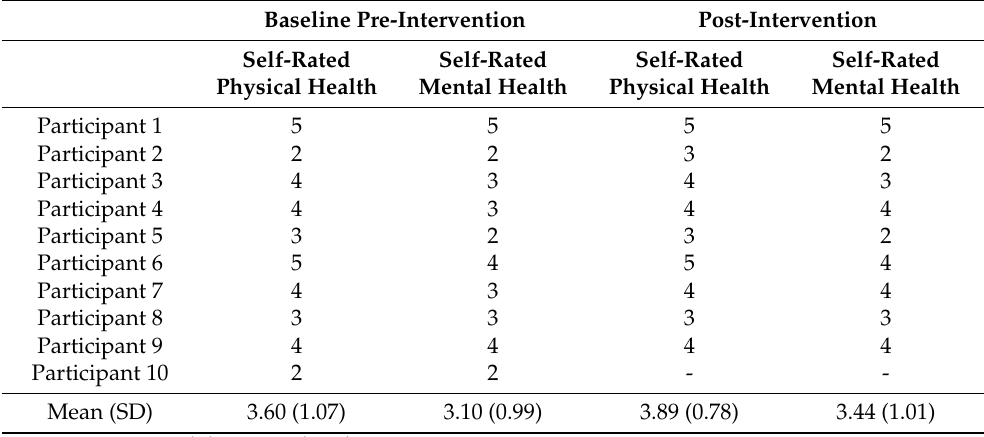
Table 3. Participants’ pre- and post-intervention self-rated physical and mental health scores (N = 10). Baseline Pre-Intervention Post-Intervention Self-Rated Physical